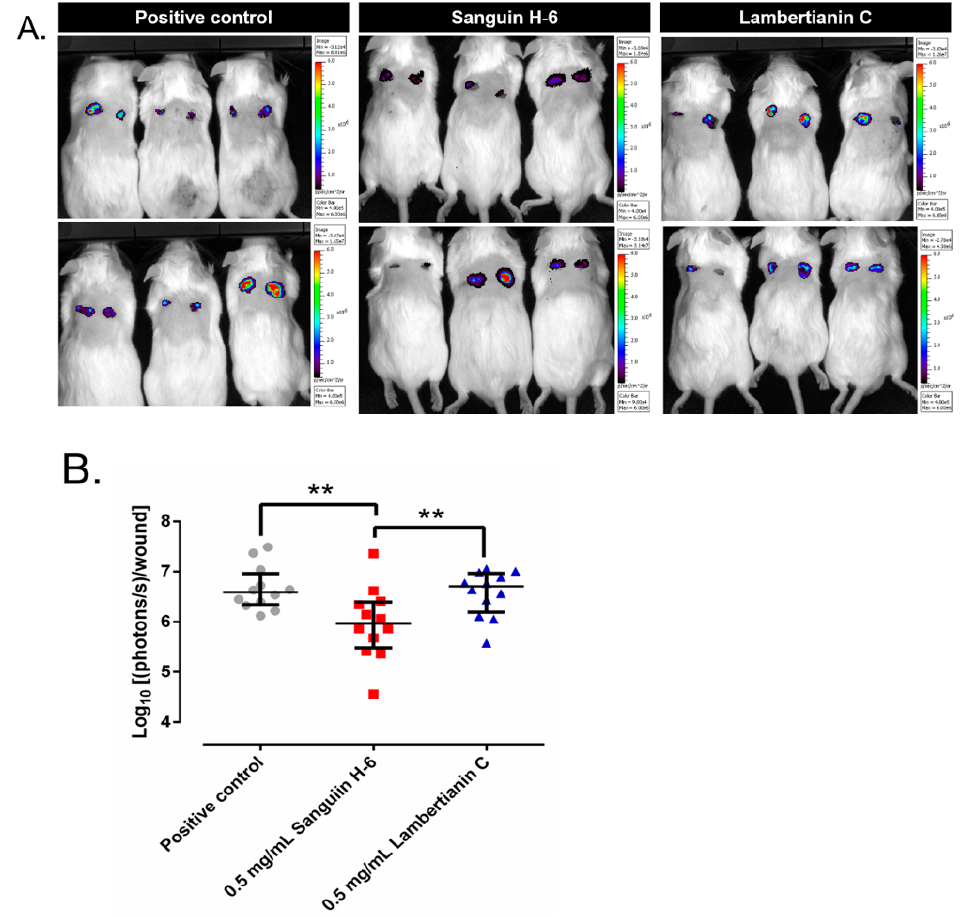
Figure 10. ( A ) Bioluminescence emitted by SAP231 (photons/s/cm 2 ) in the infected wounds of each group of mice. It is noteworthy that the bioluminescence from each wound is directly proportional to the number of live staphylococci. ( B ) Wound area in each experimental group. **: p- value < 0.01 for Wilcoxon test.